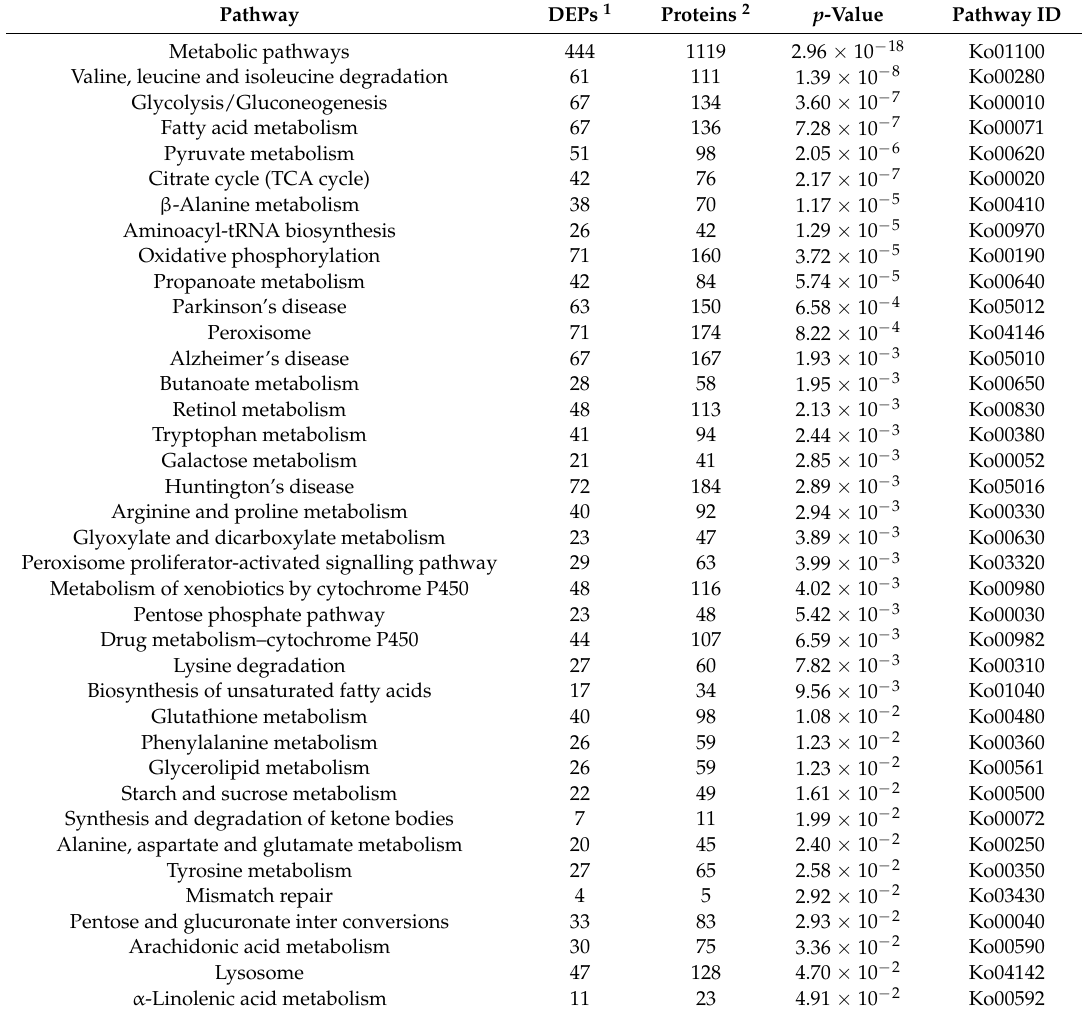
Table 3. KEGG pathways enrichment analysis in the Bursaphelenchus mucronatus ( B. mucronatus )